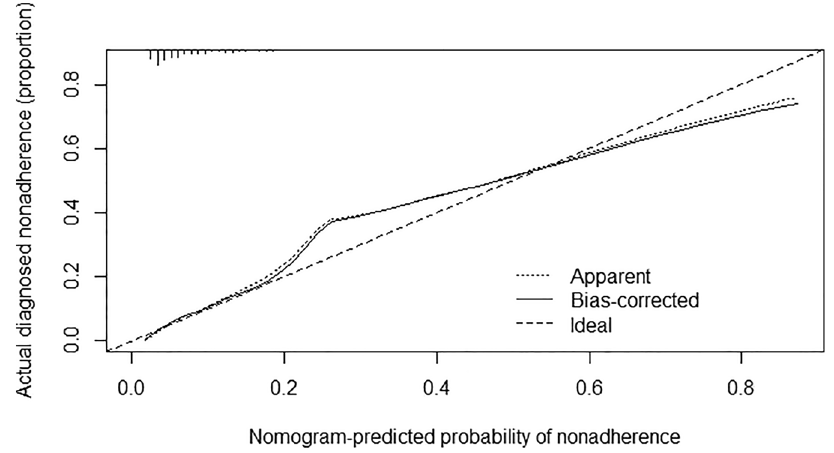
Figure 6. The calibration curve for predicting CIT in the validation